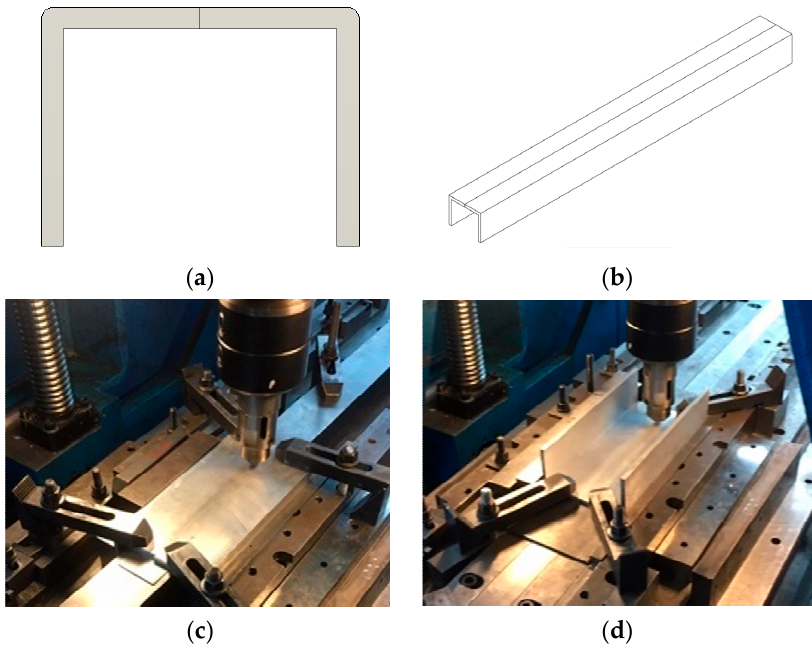
Figure 5. C-shaped channel configuration. ( a ) Transverse section of the two L-shaped profiles, ( b ) full schematic, ( c ) weld configuration downwards and ( d ) weld configuration upwards.